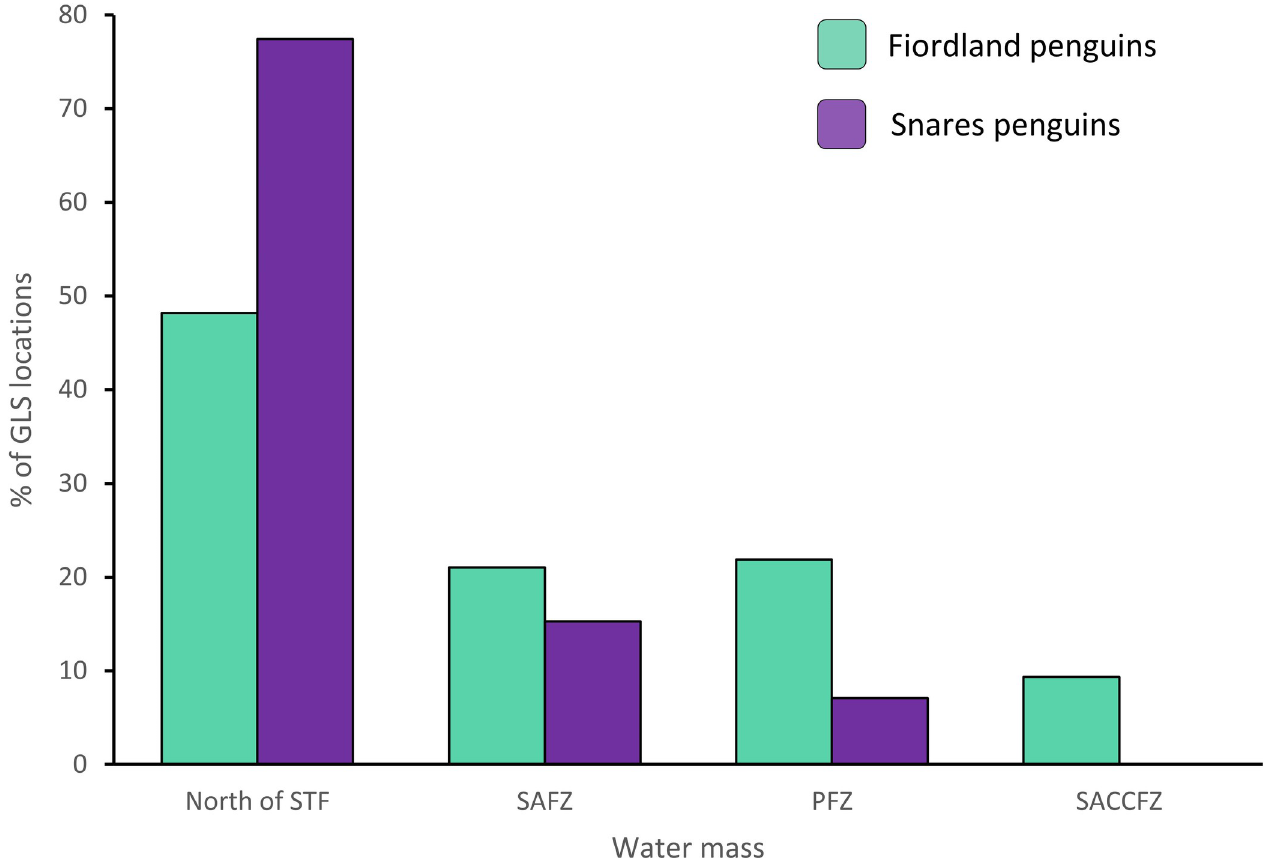
Fig 3. Usage of the different water masses by Fiordland penguins and Snares penguins during the non-breeding season. Water masses are: North of STF = north of the Sub-Tropical Front, SAFZ = Sub-Antarctic Frontal Zone, PFZ = Polar Frontal Zone and SACCFZ = Southern Antarctic Circumpolar Current Frontal Zone.